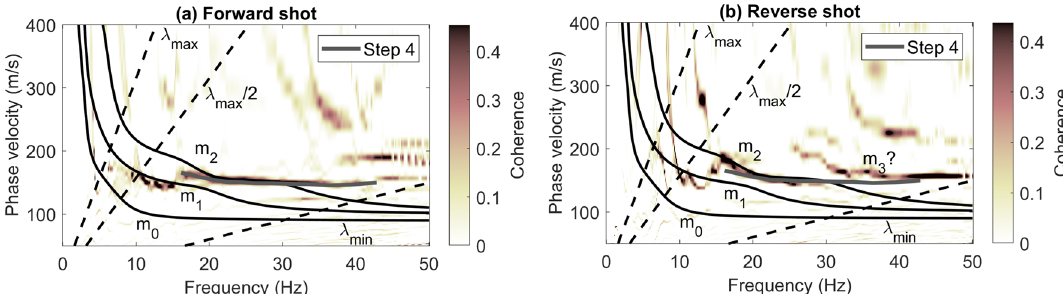
Fig. 7 High-res MASW; Forward ( a ) and reverse ( b ) direction high-resolution MASW images computed with the deblurring method (Mikesell et al. 2017). In addition, the two near-offset traces (1.5 and 3.0 m) were removed from the shot records (Fig. 3) prior to applying the MASW. A velocity-based window is also applied to time series from 50 to 600 m/s to remove energy outside this velocity range prior to MASW. Solid curves